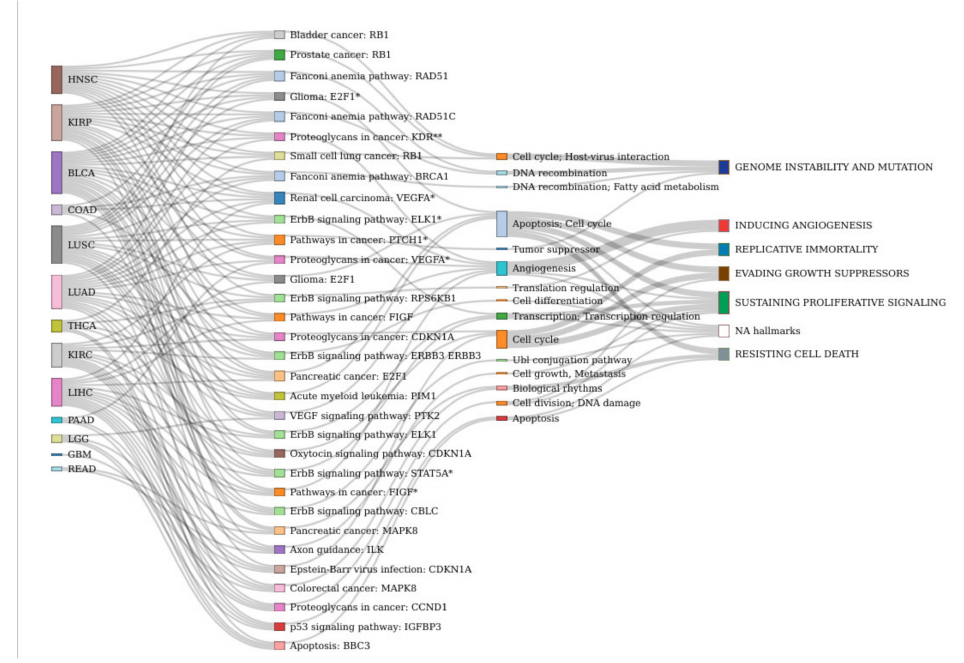
Figure 5. Relationships among cancers, signaling circuits, functions, and cancer hallmarks. * is used for disambiguation, it refers to e ff ector genes occurring more than once in the same KEGG